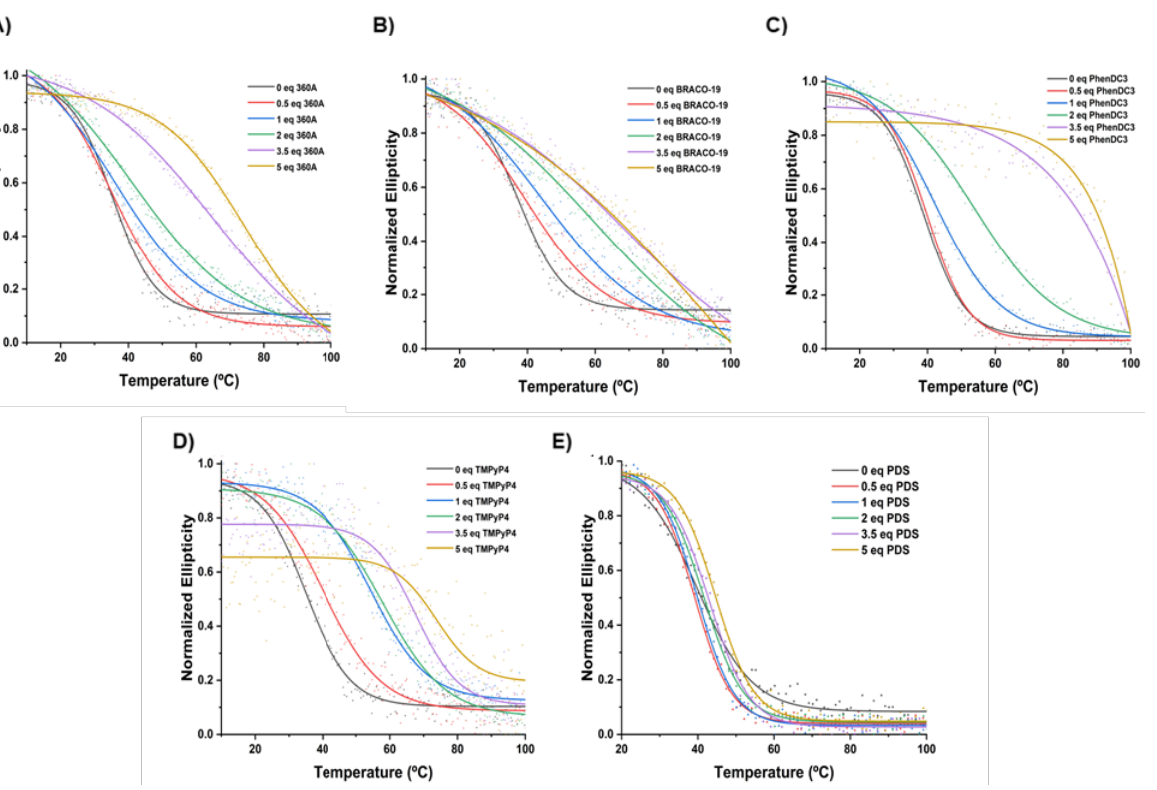
Figure 4. CD melting spectra of AT11-L2 in the absence and presence of increased molar equivalents of ligands ( A ) 360A, ( B ) BRACO-19, ( C ) PhenDC3, ( D ) TMPyP4 and ( E ) PDS. CD spectra were acquired in a buffer containing 10 mM of lithium cacodylate (pH 7.2) and 100 mM of KCl.